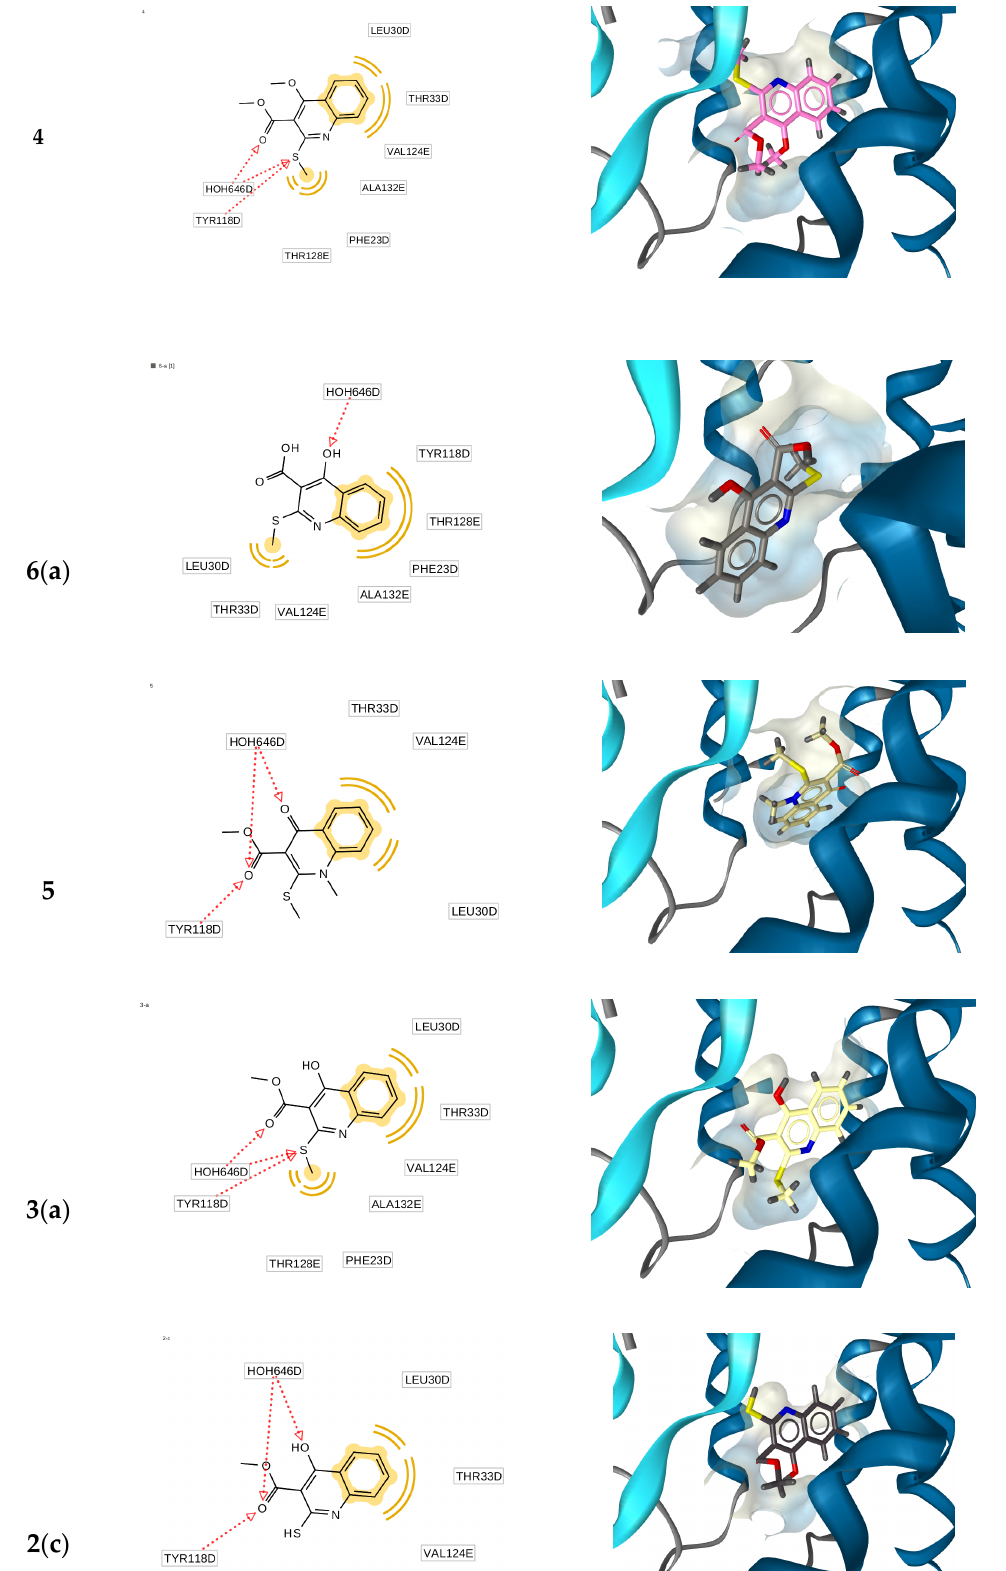
Figure 12. Complexes with highest affinity score presented according to Table 2.